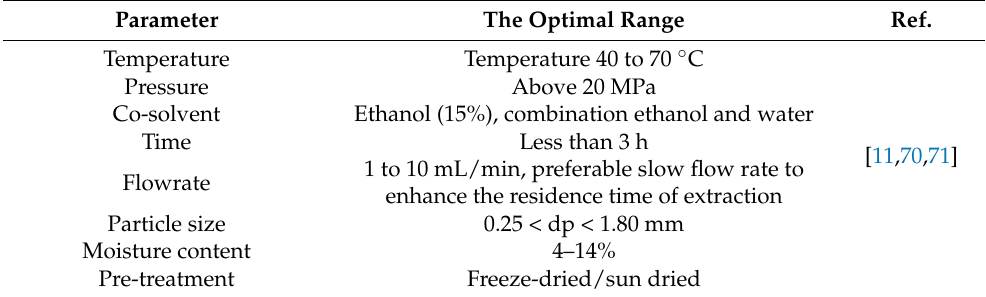
Table 4. The critical parameters in the ScCO 2 extraction in the anthocyanin